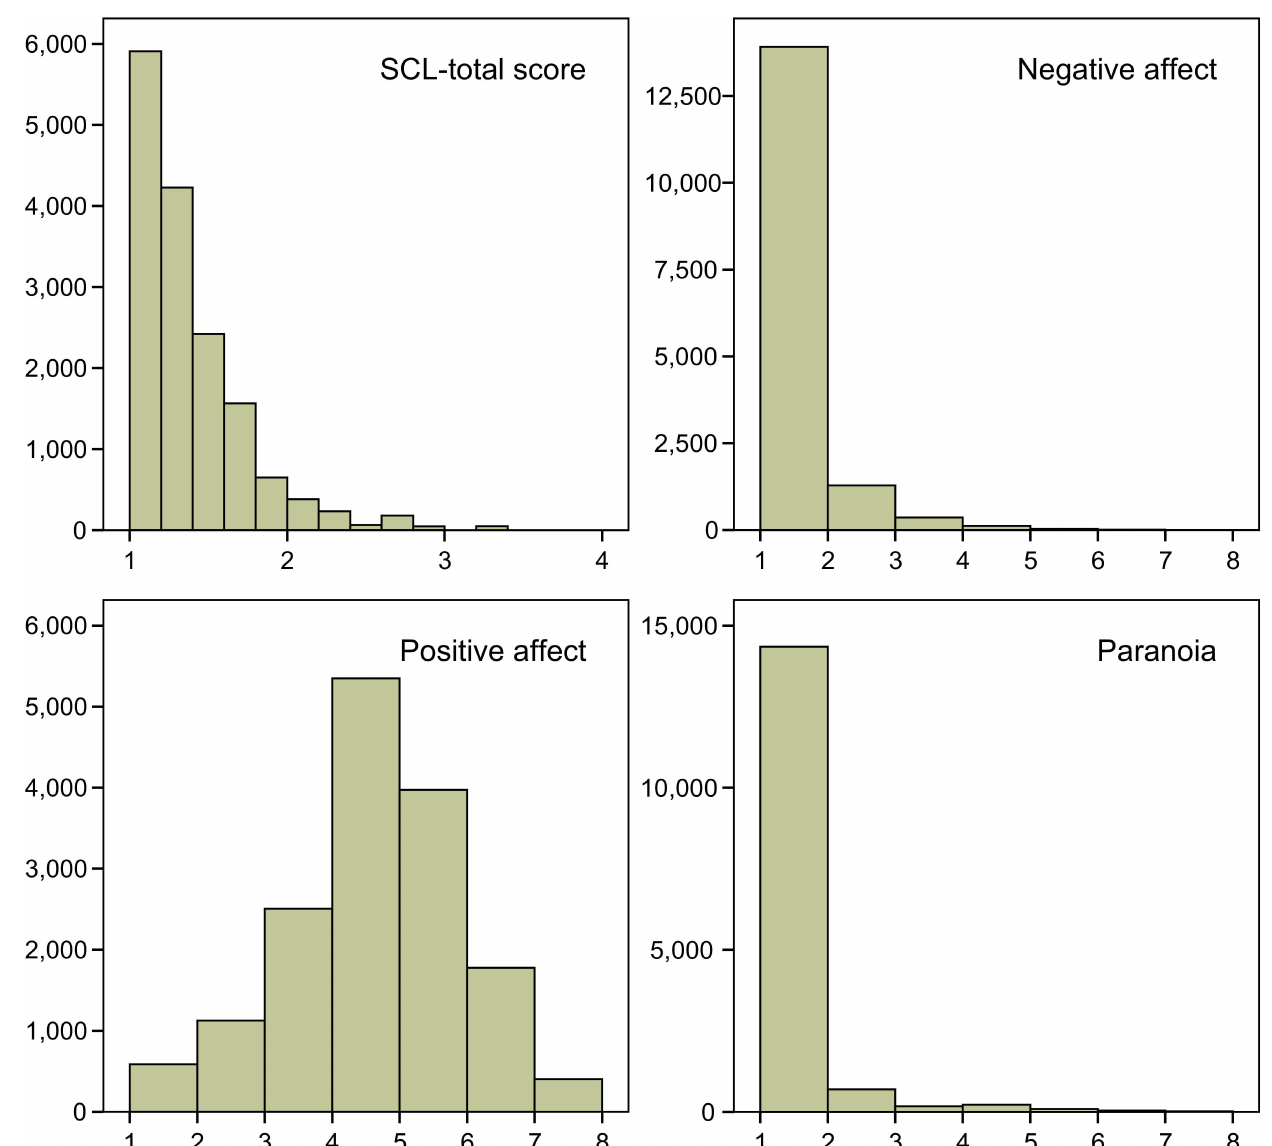
Fig 2. Distributions of the variables. Histograms of the variable scores’ distributions with the variable scores on the X-axis and frequenciesof measurements on the Y-axis.